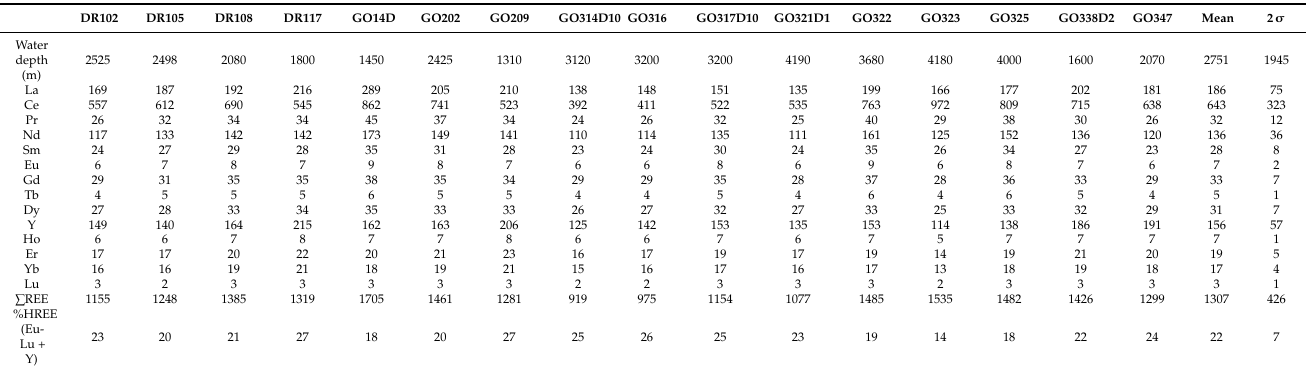
Table 4. Rare earth elements (REE) compositions of the 17 samples analysed with